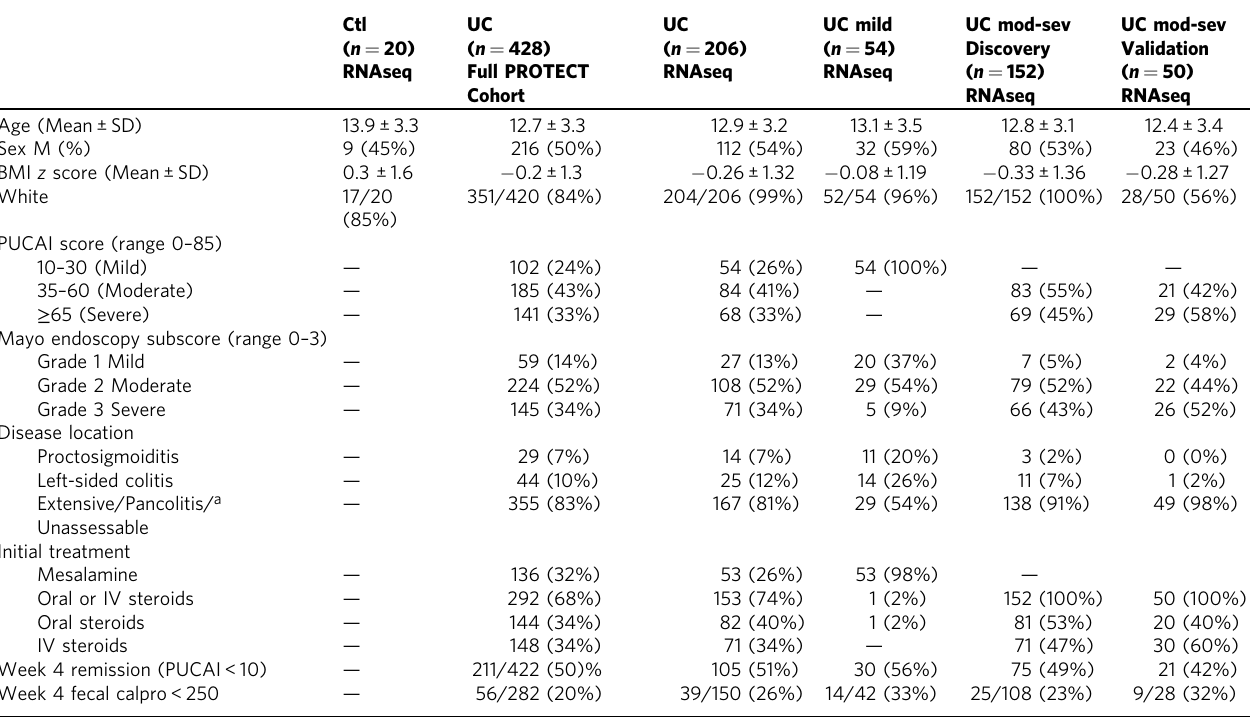
Table 1 Characteristics of controls and PROTECT ulcerative colitis discovery and validation